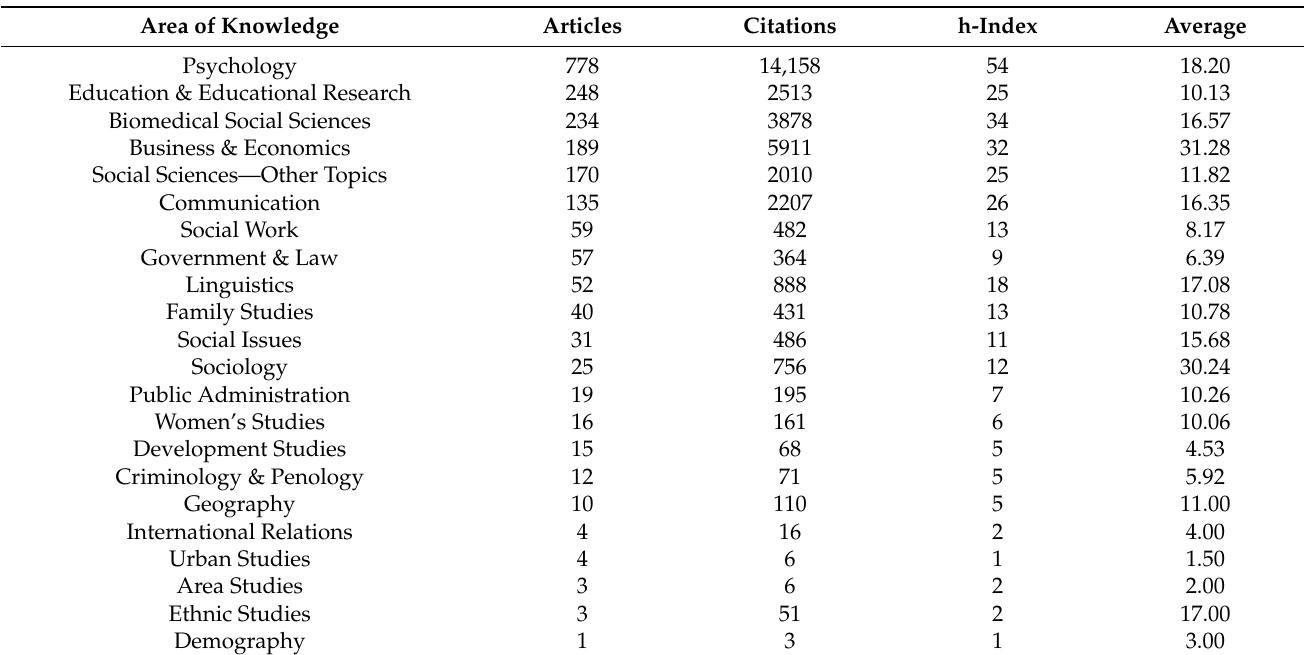
Table 6. Relevance of areas of knowledge on eHealth and social